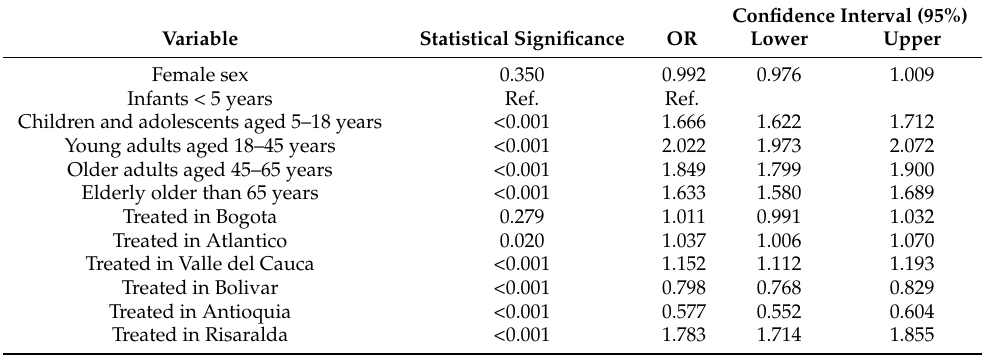
Table 3. Multivariate logistic regression analysis identifying variables associated with the use of antibiotics in a group of patients with viral respiratory tract infections,